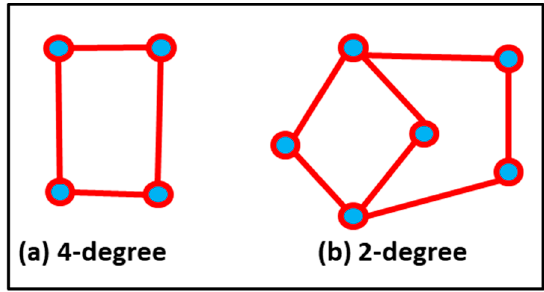
Figure 39. An example of 2- and 4-degree anonymous graph (Ref. [147]).